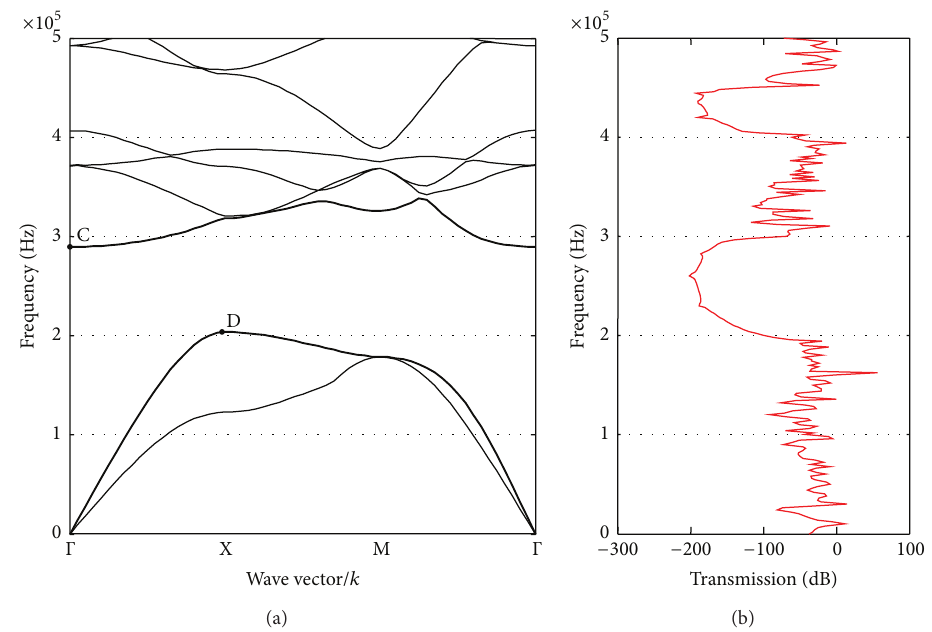
Figure 3: The dispersion curves of the phononic crystal with no microcavity structure (a) and the transmission spectra of the phononic crystal with no microcavity